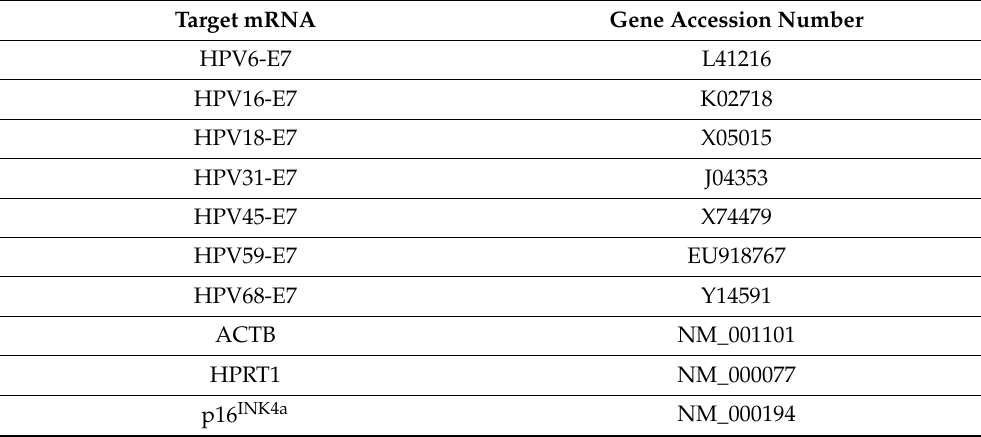
Table 1. Target mRNAs and gene accession numbers for the custom design of the QG-POC assay